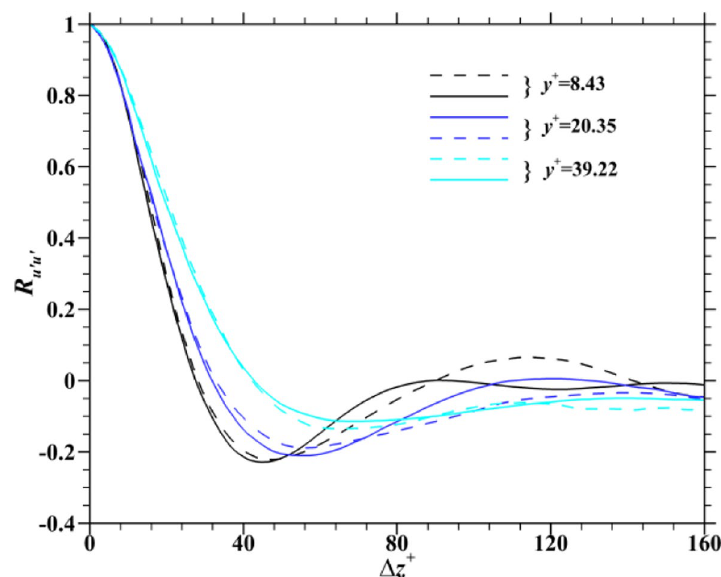
Fig. 25 Distribution of two-point correlations in the span-wise direction at different heights from the wall (solid: riblet case; dash-dot: smooth case)